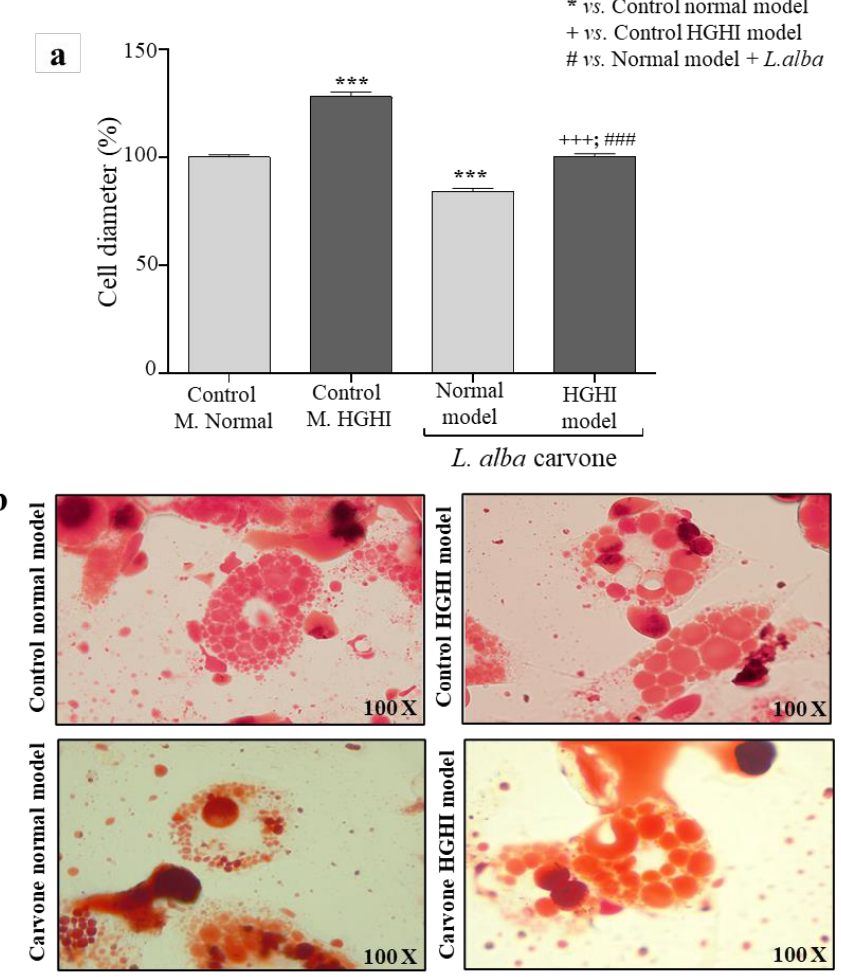
Figure 2. Adipocyte cell size. ( a ) Cell area percentage of adipocytes treated with 5 µg/mL of the carvone chemotype Lippia alba EO from normal and pathological model-HGHI; ( b ) triglyceride staining by Oil Red-O in normal adipocytes and the pathological model of obesity and insulin resistance (HGHI) in vitro, treated and untreated (control) with the carvone chemotype Lippia alba EO. *** p < 0.001 with respect to control model without EO; +++ p < 0.001 with respect to the pathological model without EO treatment; ### p < 0.001 with respect to control model treated with EO.